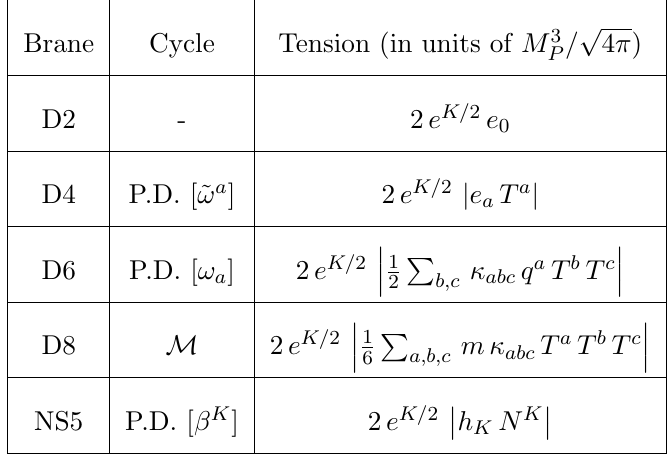
Table 1. Tensions of the di(cid:11)erent domain walls obtained by wrapping one kind of D p or NS5-brane around a given supersymmetric cycle on the Calabi-Yau manifold. The number of branes wrapped on the same cycle is counted by the corresponding (cid:13)ux at the other side of the wall divided by 2. Summation over repeated indices should only be understood when explicitly